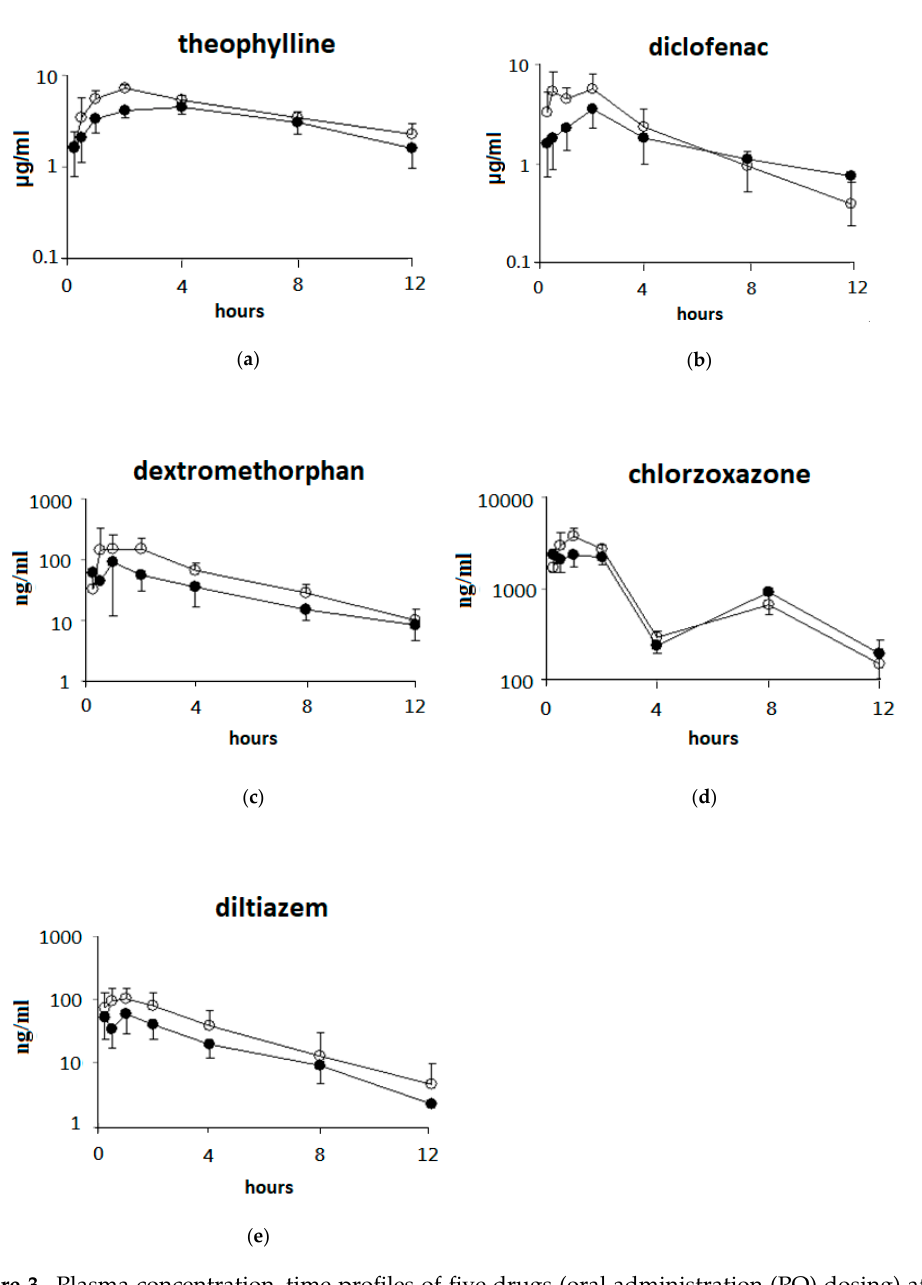
Figure 3. Plasma concentration–time profiles of five drugs (oral administration (PO) dosing) after administration of a single oral dose of ABO in rats. The drug cocktail (CYP1A2: theophylline ( a ), CYP2C: diclofenac ( b ), CYP2D: dextromethorphan ( c ), CYP2E1: chlorzoxazone ( d ), CYP3A: diltiazem ( e ) was administered orally at a dose of 5–40 mg / kg BW to rats 1 h after administration of 2.5 mg / kg BW of control oil or ABO. Values at each time point are expressed as the mean ± SD of six rats in each group. (cid:8) : Control group; : ABO (cid:35)